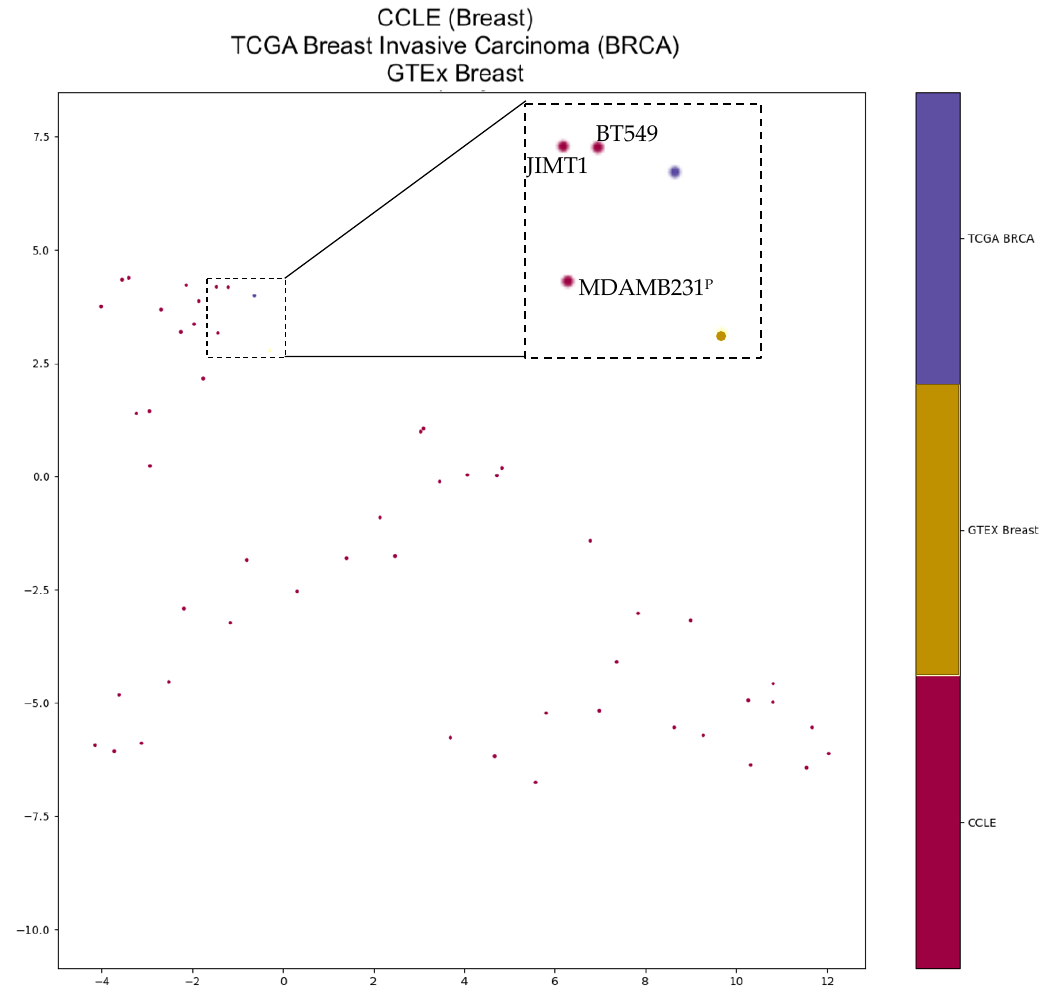
Figure 6. UMAP projection of breast CCLE cell lines, TCGA breast invasive carcinoma (BRCA), and GTEx breast using TERT isoform expression. Cell lines JIMT1 and BT549 were closest to average isoform percentage from TCGA BRCA. Cell line MDAMB231 was closest to average isoform percentage from GTEx breast. Cell line TERT promoter status taken from Ghandi et al., 2019. Superscript “P” indicates TERT promoter mutation, superscript “WT” indicates wild-type TERT promoter, and no superscript indicates no data available. Dashed-line box indicates a zoomed in region of interest with text labels of cell lines. UMAP Parameters: Manhattan distance, 8 Neighbours and 4 Components.